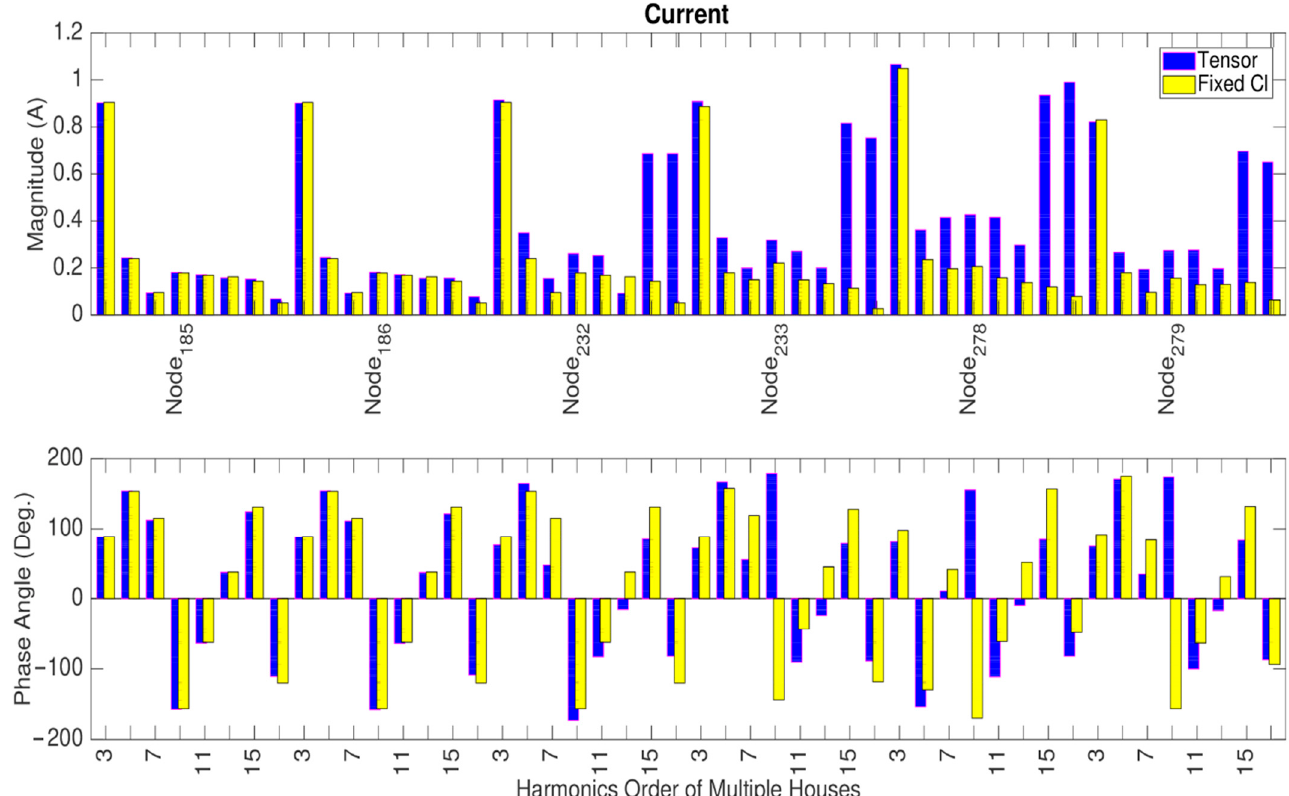
Figure 10. Urban LV network (90%).